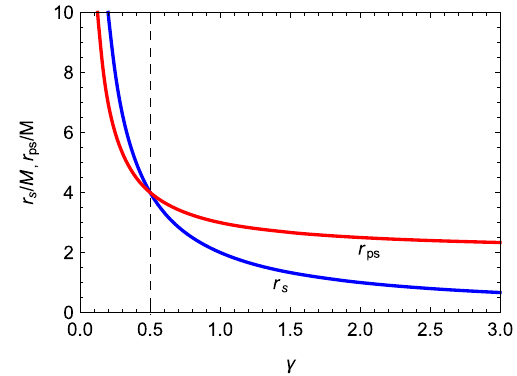
Fig. 1 Variation of the photon capture radius ( r ps ) and the singularity ( r ) on the equatorial plane as functions of γ . The solid red line cor- s responds to r ps and the solid blue line represents r s . We have chosen M = 1 to obtain the plots. For γ < 0 . 5, we see that r ps < r s , i.e., the singular surface is outside the photon capture circle